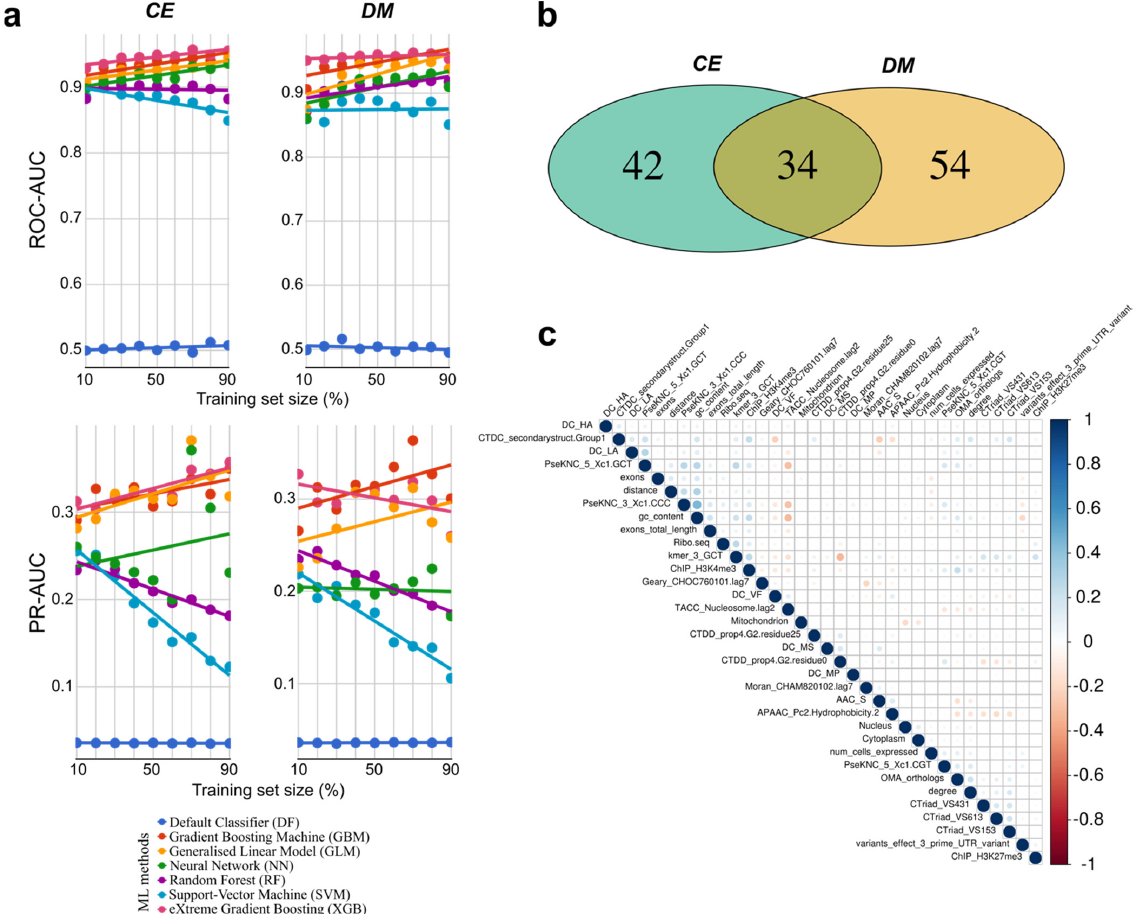
Figure 1. Evaluation of essential gene predictions within species using standardised/consensus features for Caenorhabditis elegans ( CE ) and Drosophila melanogaster ( DM ). ( a ) For each species, subsets (10–90%, 10% increments) of high-confidence essential and non-essential genes [22,23] were randomly selected ( x -axis) to train six machine learning approaches/methods, following a feature selection strategy. Prediction performance (ROC-AUC and PR-AUC) was evaluated using the remaining data. ( b ) Venn diagram of the best-predictive features identified for CE and/or DM . ( c ) Pairwise correlations between the 34 best-predictive features identified for both species.